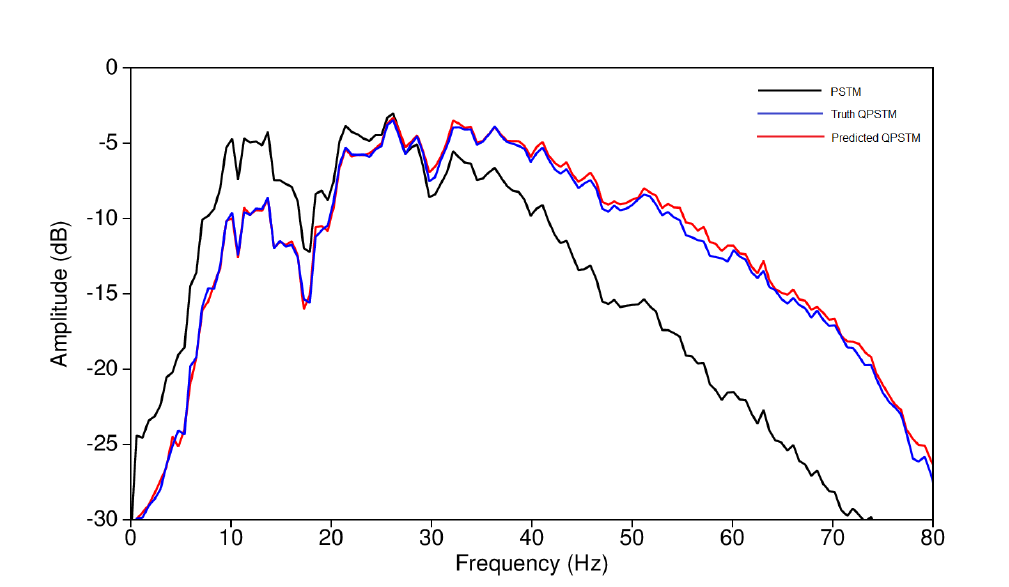
Figure 15. Comparing the spectra of the ground truth QPSTM and predicted QPSTM. Using the learning method, the frequency improved by approximately 16 Hz at the high-frequency end at − 20 dB compared with that of the conventional PSTM. The learned method and QPSTM exhibited comparable performances in terms of the frequency improvement.